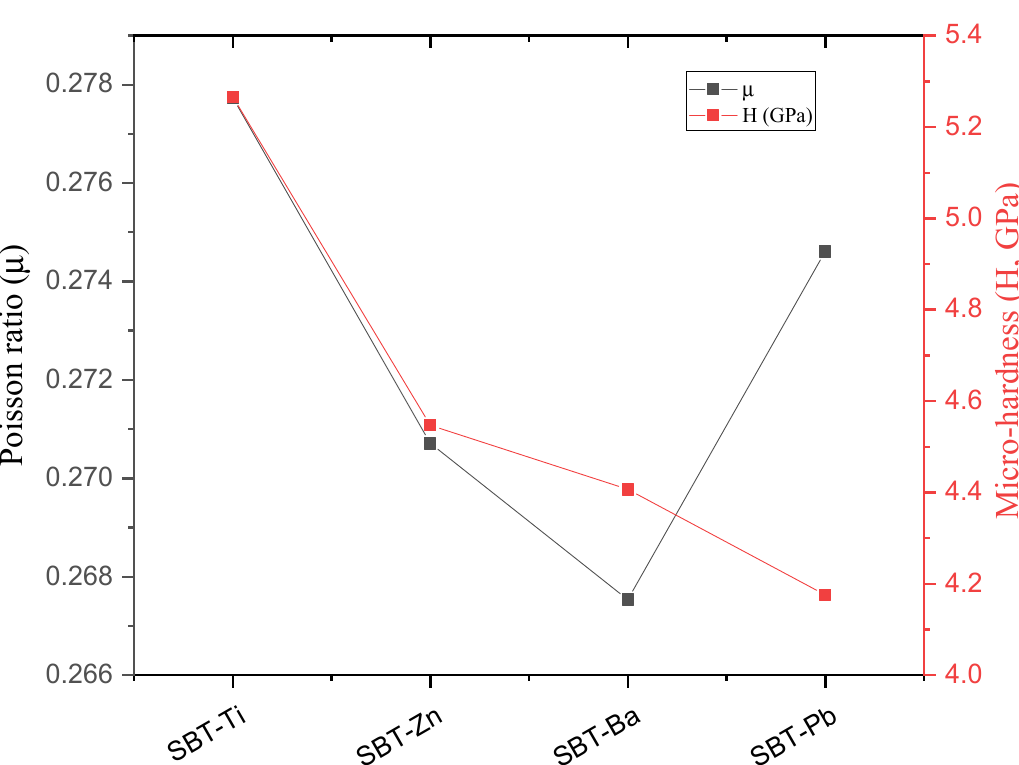
Figure 5. The correlation between Poisson ratio ( µ ) and micro-hardness (H) of the fabricated SBT glasses.